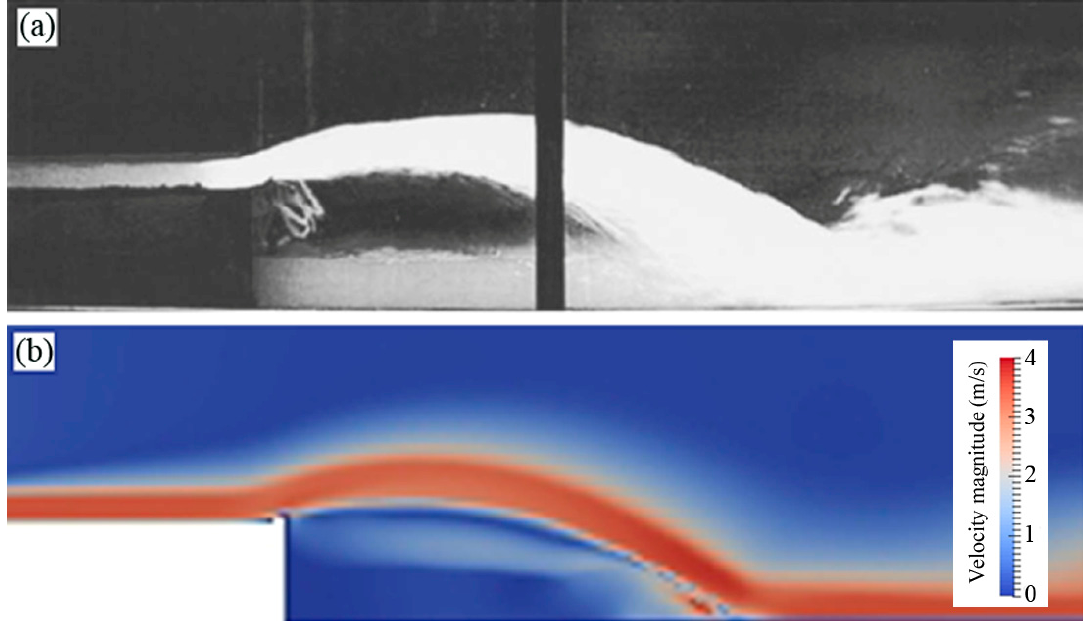
Figure 5. Visual comparison between the ski jump jets for R = 0.10 m, β = 40°, h 0 = 0.05 m, F 0 = 5 (test no. 27 in Table 1: ( a ) physical experiment [15] (reproduced with permission from ASCE); ( b ) numerical results of the present study (note: the darkest red color represents velocity magnitudes of 4 m/s and larger).